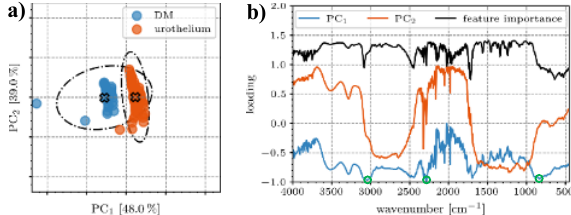
Fig. 2. Scores a) and loadings b) plot of a PCA showing the first two PCs that describe nearly 90 % of the data. A distinct separation of DM and urothelial tissue can be observed.